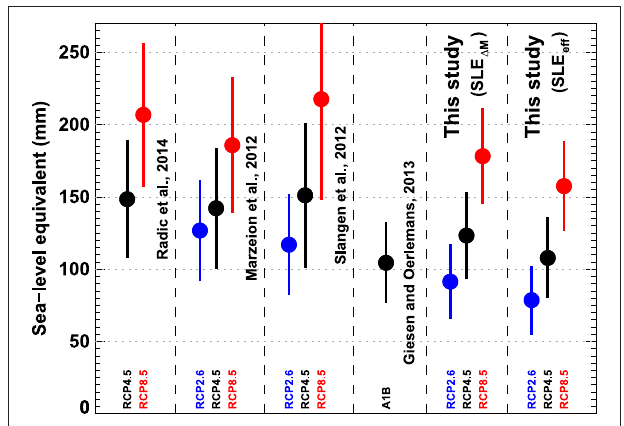
FIGURE 13 | Comparison of modeled twenty-first century sea-level equivalent from glacier mass loss based on previous assessments included in IPCC (2013) with results from this study. Circles refer to multi-model means from 8 to 15 GCMs and bars indicate ± 1 σ . Previous results are recomputed to refer to the period 2010–2100 -by assuming their average rates to be constant in time. Results of this study are given both as SLE 1 M and SLE eff while the results from previous studies denote SLE 1 M